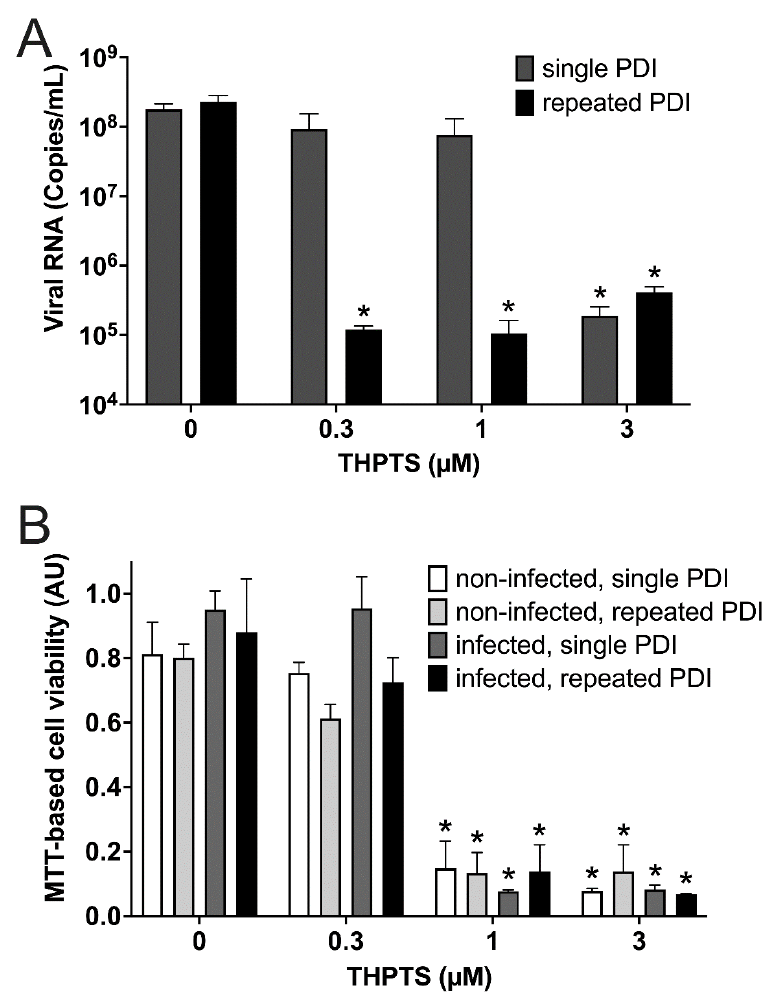
Figure 5. Results from photodynamic inactivation treatment of Vero cell cultures after infection with SARS-CoV-2. ( A ) Viral RNA was detected after SARS-CoV-2 infection of Vero cell cultures and subsequent single (5 min) or repeated PDI (5 min every 4 h for 3 d) at different photosensitizer (PS) concentrations. ( B ) Cell viability was determined by an MTT-based assay for mitochondrial activity. Data are presented as mean and SD. * p < 0.05 when compared to respective samples treated with 0 µM THPTS.